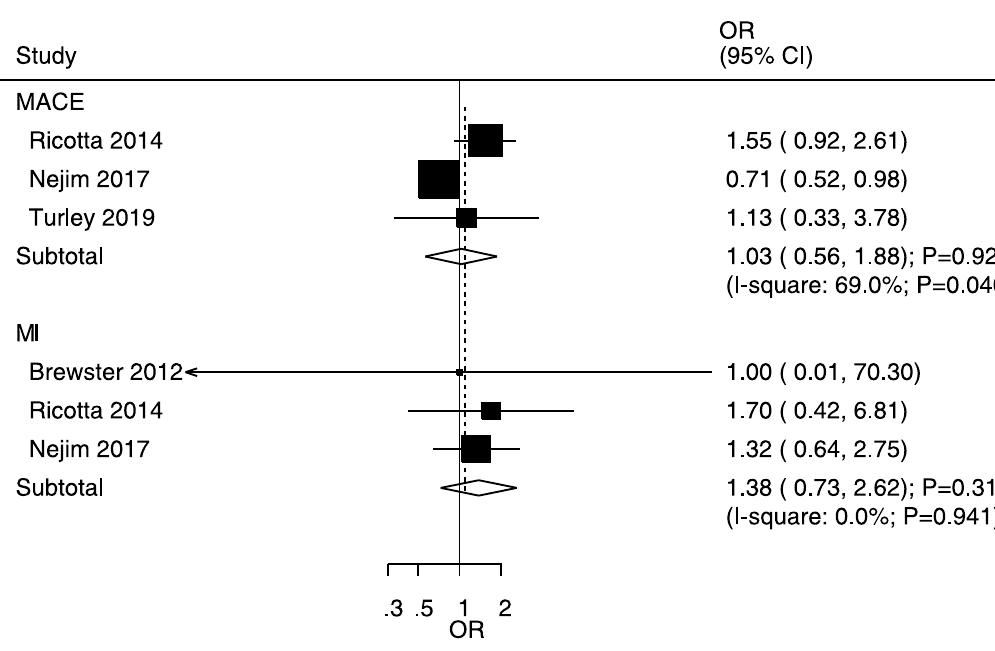
Fig 4. Effects of carotid endarterectomy (CEA) versus Carotid Artery Stenting (CAS) on the risks of myocardial infarction and major adverse cardiovascular events.